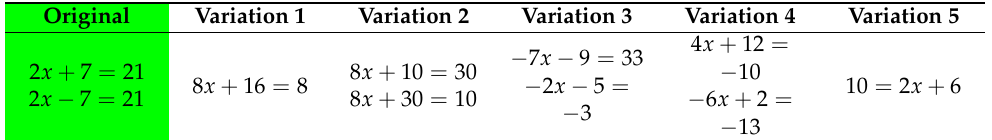
Table 8. Examples of type 7 equations and